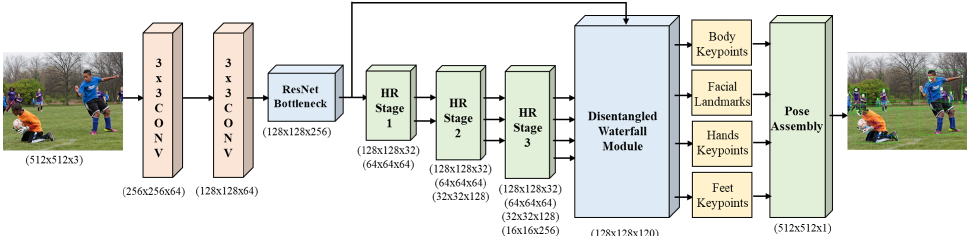
Figure 2. Full-BAPose architecture for whole-body multi-person pose estimation. The input color image is fed through the HRNet backbone for initial feature extraction. The feature sizes are denoted by the two spatial dimensions first and the channel dimension last, e.g., (128 × 128 × 32) denotes feature size of 128 × 128 with 32 channels. The HRNet features are combined by the D-WASP module and a decoder utilizing adaptive convolutions generates the detection bounding boxes and the keypoints for the hand, head, feet, and entire body, i.e., 133 keypoints and 4 bounding boxes for each person